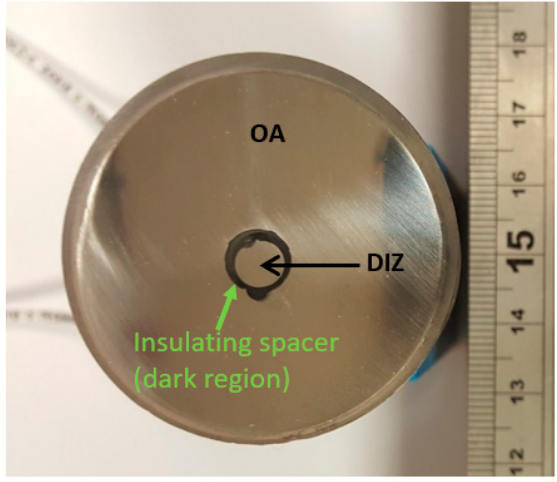
Figure 3. Segmented sample encapsulated in epoxy resin.